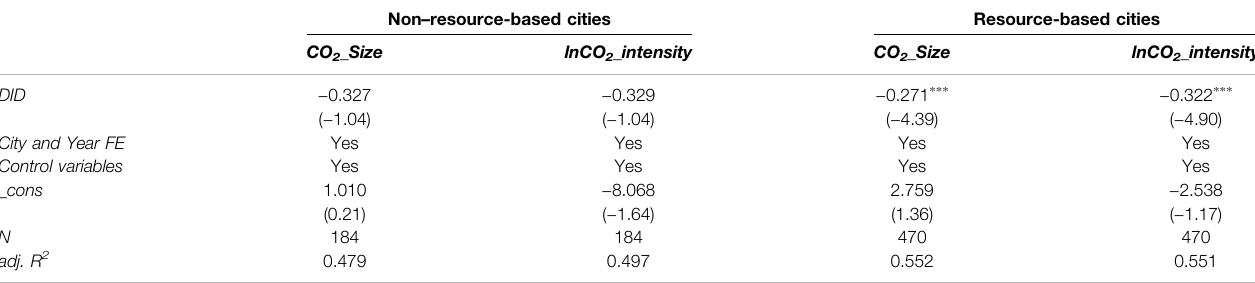
TABLE 7 | Heterogeneity of urban attributes.